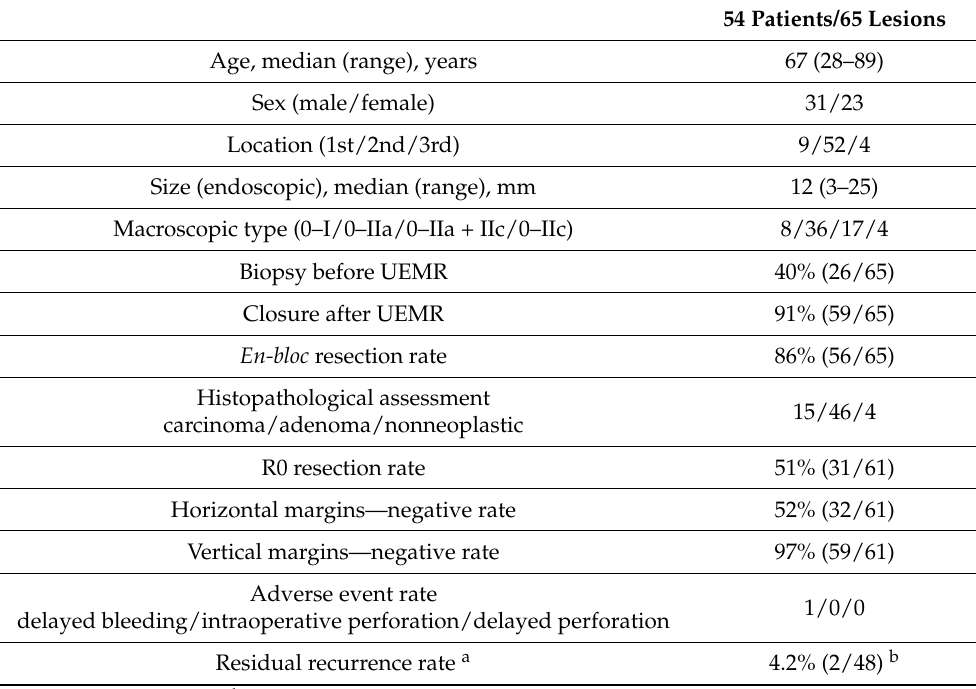
54 Patients/65 Lesions